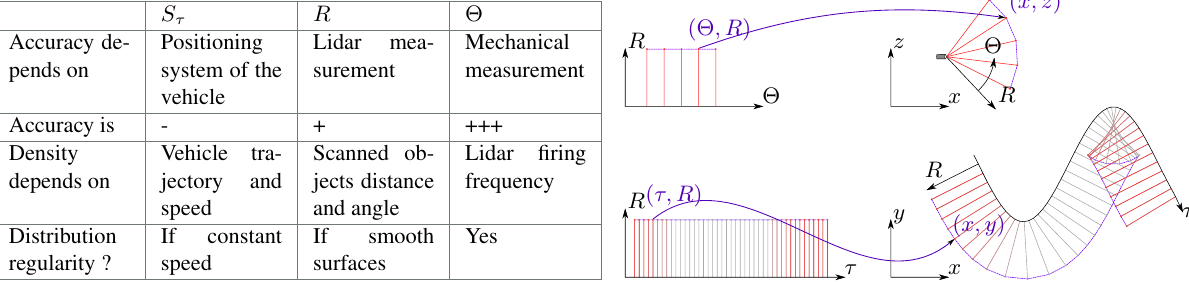
Table 1: Accuracy and Distribution of S τ , R and Θ .